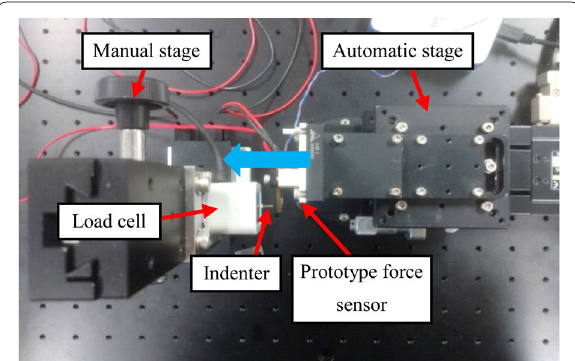
Fig. 7 Experimental apparatus for evaluating force sensor.